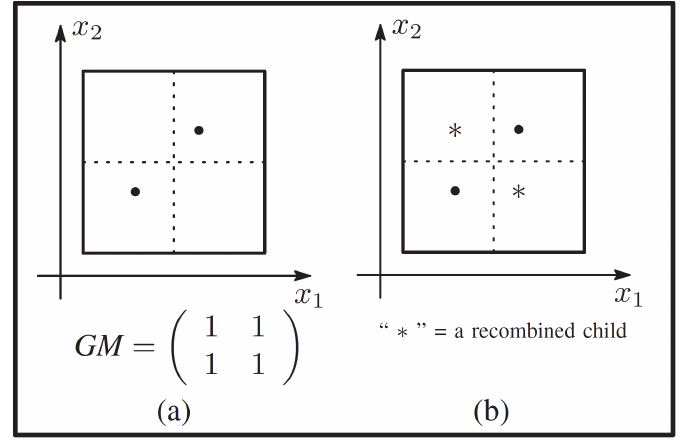
Figure 3. The role of recombination operation and GM